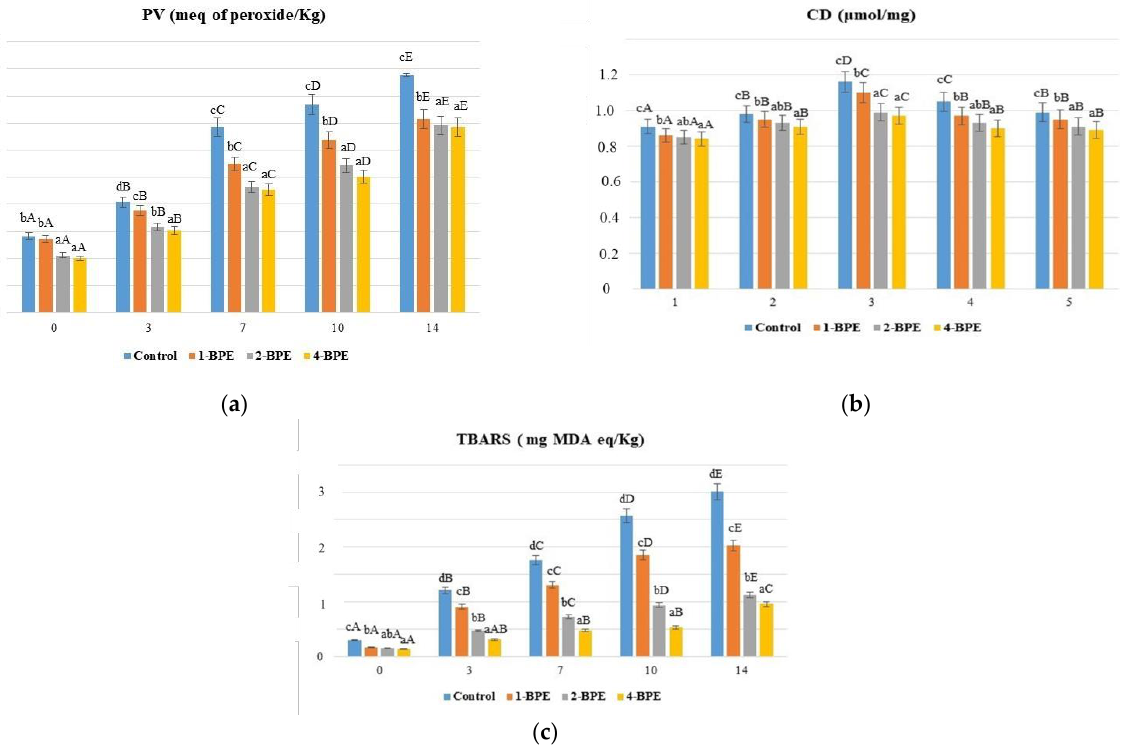
Figure 4. Effect of the films (control (0%), 1-BPE (0.25%), 2-BPE (0.5%), and 4-BPE (1%)) on ( a ) PV (meq of peroxide/Kg), ( b ) CD (μmol/mg of meat) , and ( c ) TBARS (mg MDA-eq/Kg) of raw minced meat beef stored at 4 °C over 14 days; ±: standard deviation (SD) of three replicates; a – d: mean values within all the samples not followed by a similar letter in the same column varied significantly ( p < 0.05); A – E: mean values during storage not followed by a similar letter in the same line varied significantly ( p < 0.05).